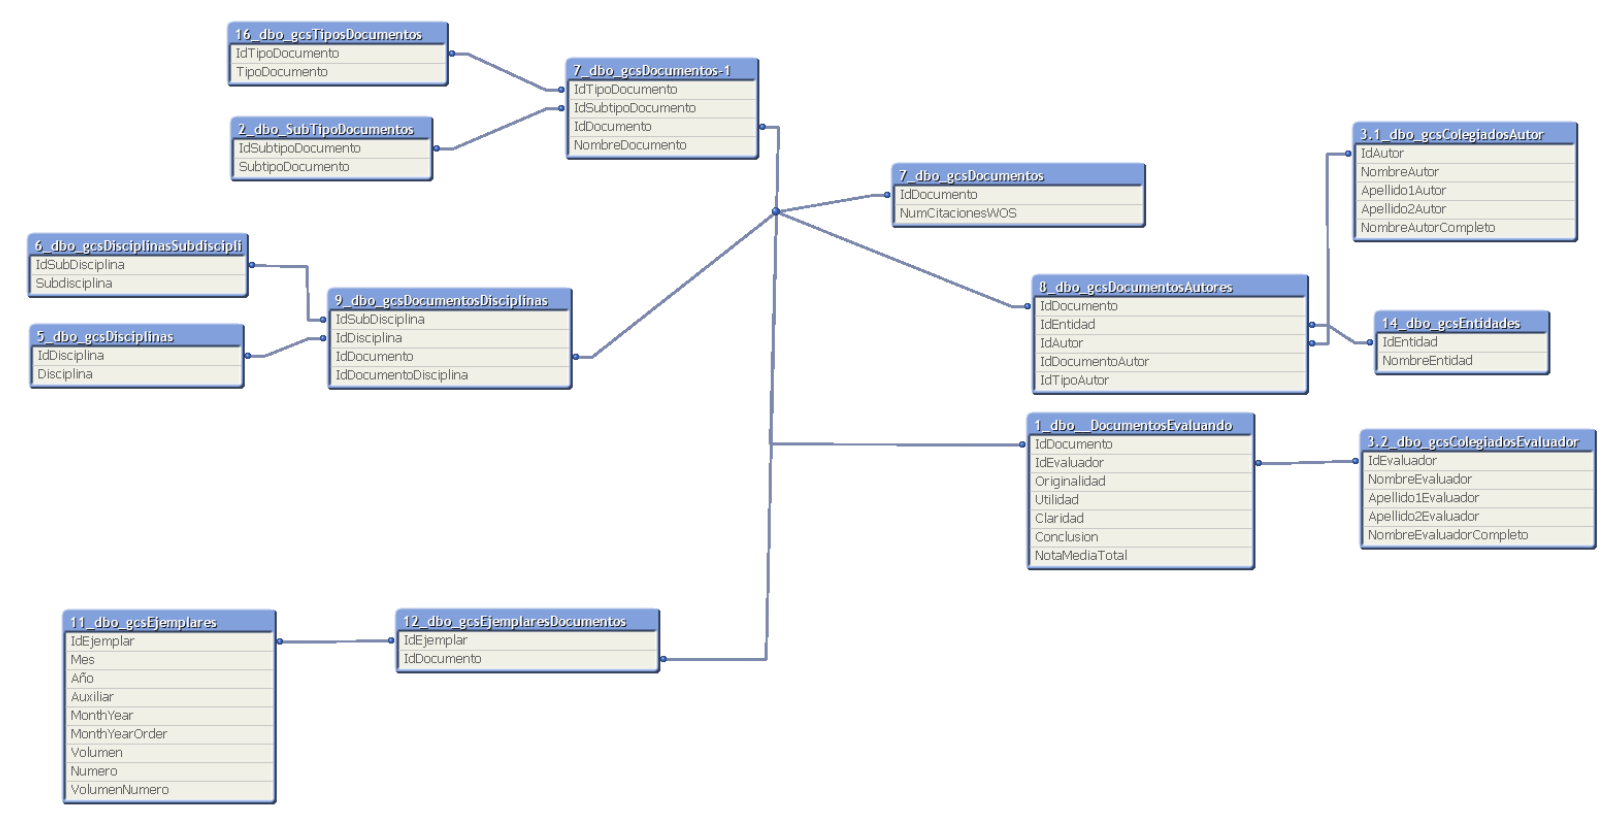
Figure 1. Data model automatically developed by the BI system in the process of reading the data sources [23].